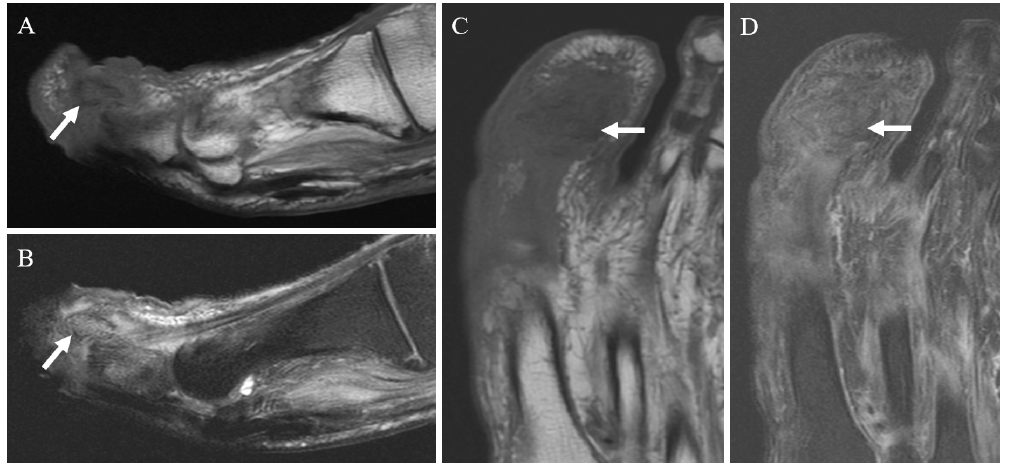
Figure 4. Sagittal T1 (a) and T2 fat-saturated (b) and coronal T1 (c) and T2 fat-saturated (d) images in a 55-year-old male patient with a great toe ulcer demonstrate confluent T1 hypointense and T2 hyperintense signal in the first distal phalanx (arrows), consistent with osteomyelitis. Table 1. Patient demographics, in total and for each T1 signal group.